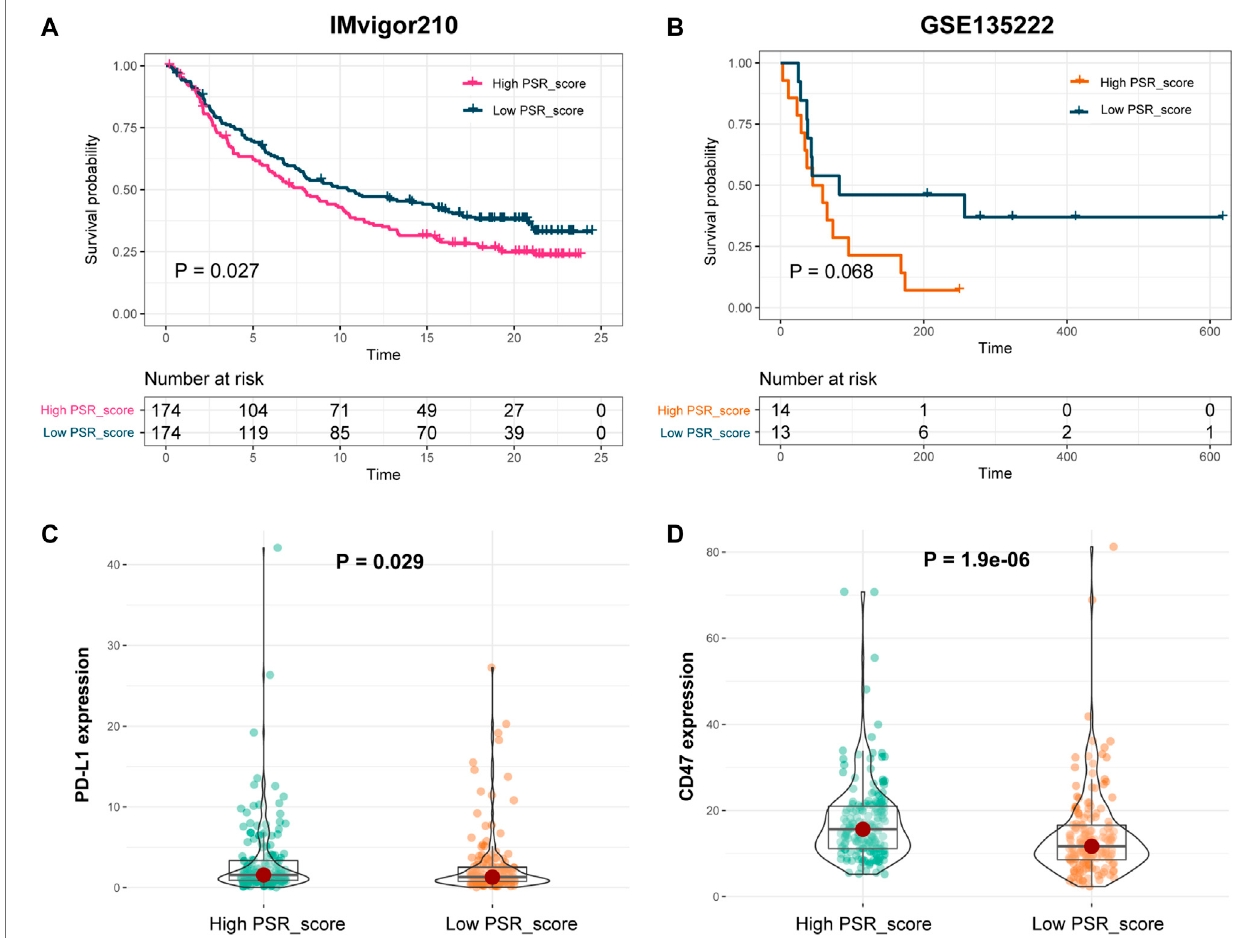
FIGURE 7 | Prognosis power of PSR_score in patients with immunotherapy. (A – B) Log-rank test was used to assess the difference in OS between high and low PSR_score samples in IMvigor210 and GSE135222 cohorts. (C – D) Expression of PD-L1 and CD47 in high and low PRG_score groups in the IMvigor210 cohort.